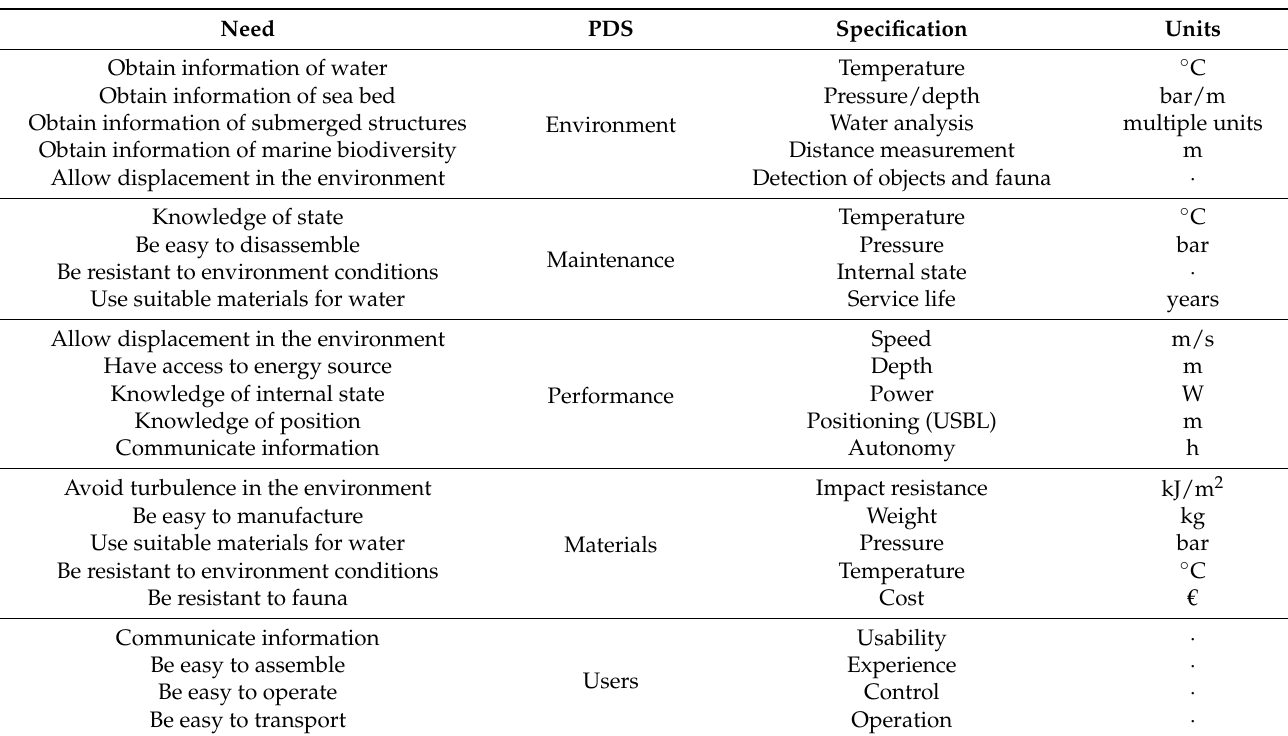
Table 2. Proposal for the characterization of the obtained PDS.